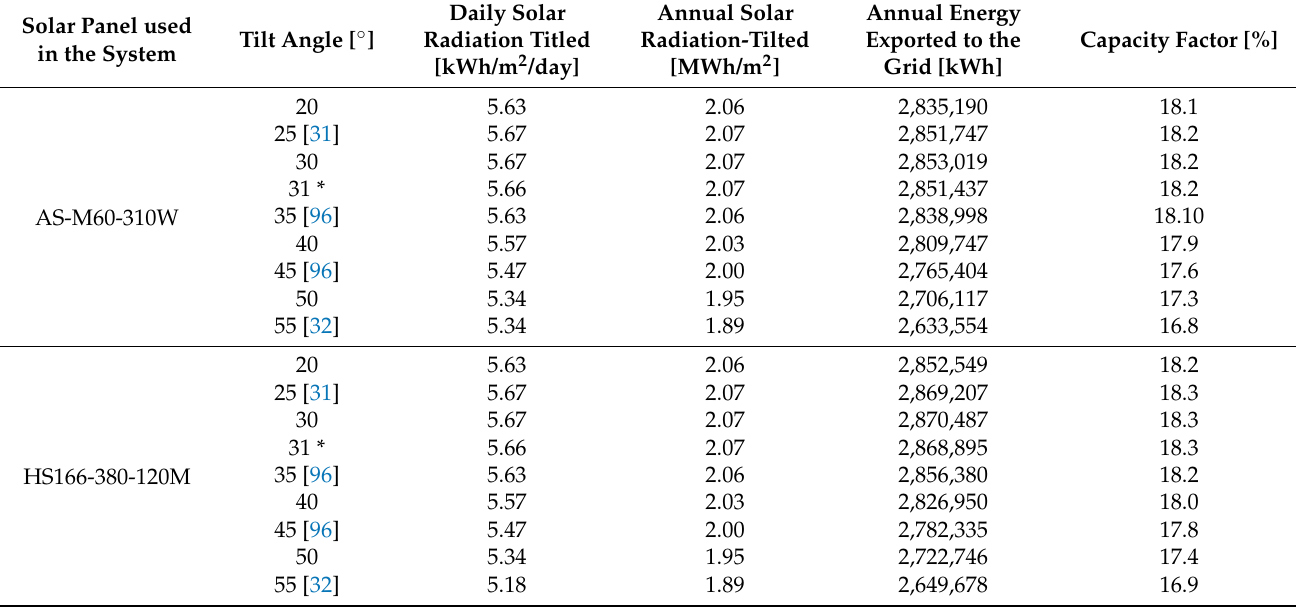
Table 5. Daily solar radiation titled, annual solar radiation-tilted and the annual energy exported and the capacity factor for various tilt angle and azimuth angle = 0°. Solar Panel used in the System